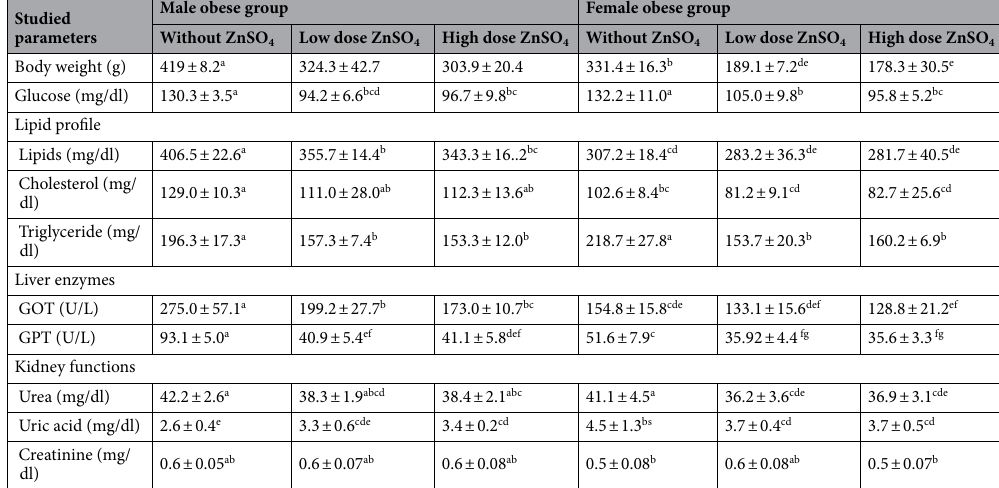
Table 5. Comparison between body weight, serum glucose level, lipid profile, liver and kidney functions in males versus female obese groups without ZnSO 4 tretatment, low dose (15 mg) ZnSO 4 treatment, and high dose (30 mg) ZnSO 4 treatment. Data was expressed using mean ± SD. Means in the same raw with small common letters are not significant (i.e. means with different letters are significant). SD Standard deviation.